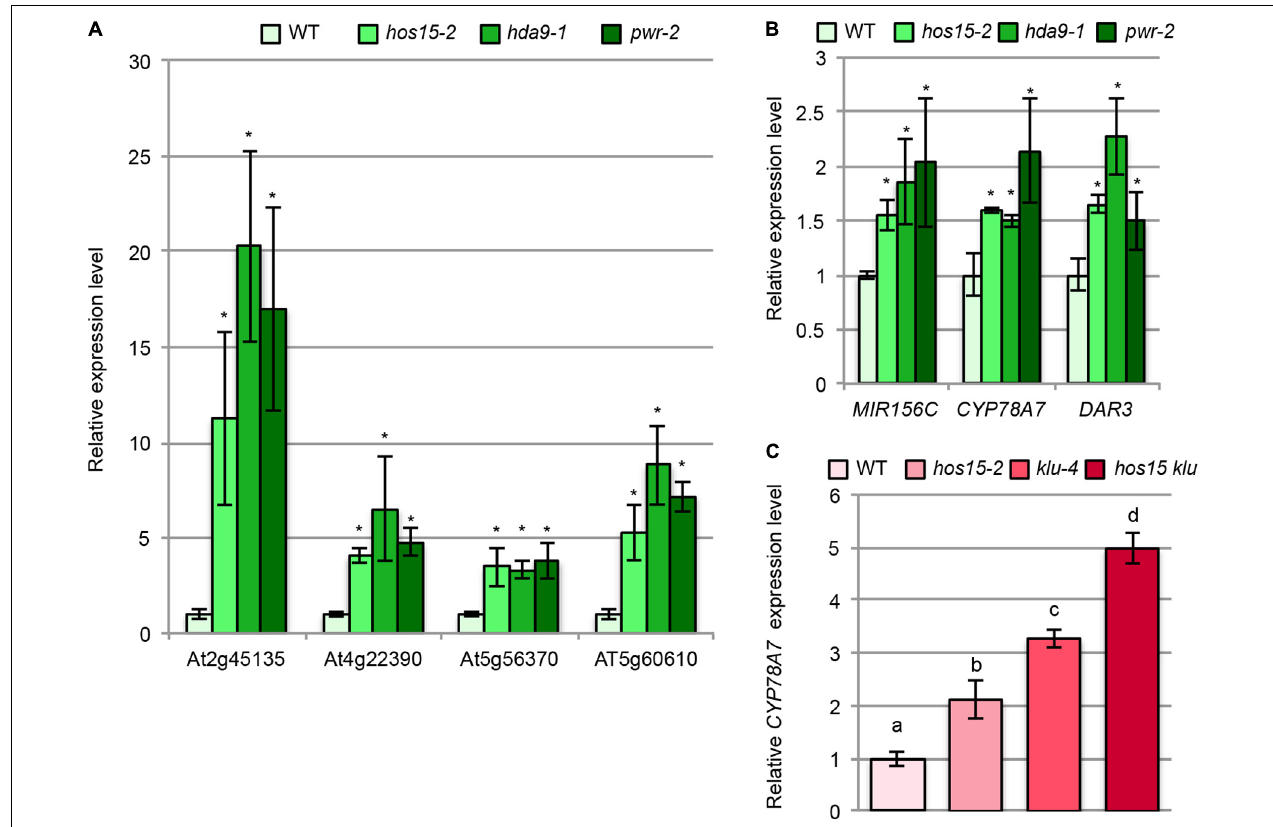
FIGURE 7 | Expression analyses of the putative downstream genes of HOS15, HDA9, and PWR. (A,B) Total RNA from the shoots of 10-day-old WT, hos15-2 , hda9-1 , and pwr-2 seedlings were subjected to RT-qPCR analyses. (C) Total RNA from the shoots of 10-day-old WT, hos15-2 , klu-4 , and hos15-2 klu-4 seedlings were subjected to RT-qPCR analyses. n = 3, mean ± SD. Statistical analyses in (A) and (B) utilized Student’s t -test ( p < 0.05) while that in (C) utilized one-way ANOVA with Tukey’s HSD test ( p <